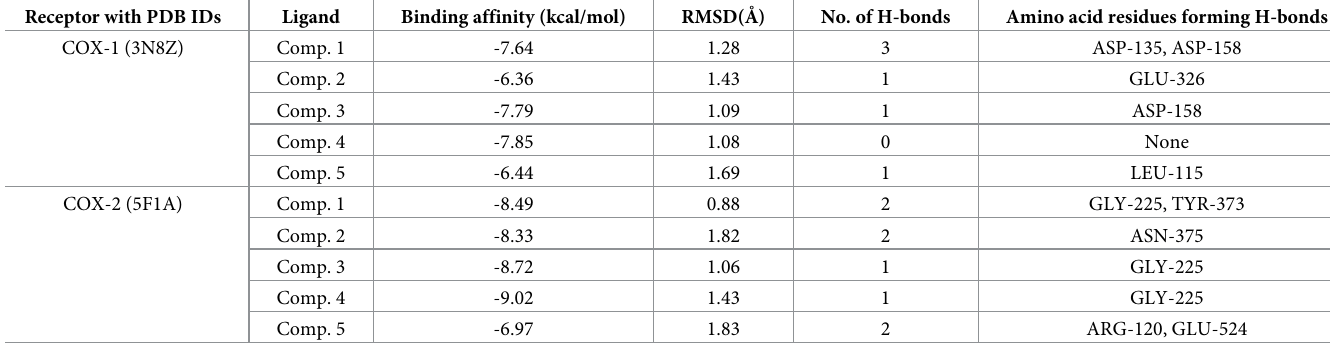
Table 1. Docking results of all the 5 sterols against COX-1 and -2 receptors. Receptor with PDB IDs Ligand Binding affinity (kcal/mol) RMSD( Å ) No. of H-bonds Amino acid residues forming H-bonds COX-1 (3N8Z) Comp. 1 Comp. 2 Comp. 3 Comp. 4 Comp. 5 COX-2 (5F1A) Comp. 1 Comp. 2 Comp. 3 Comp.